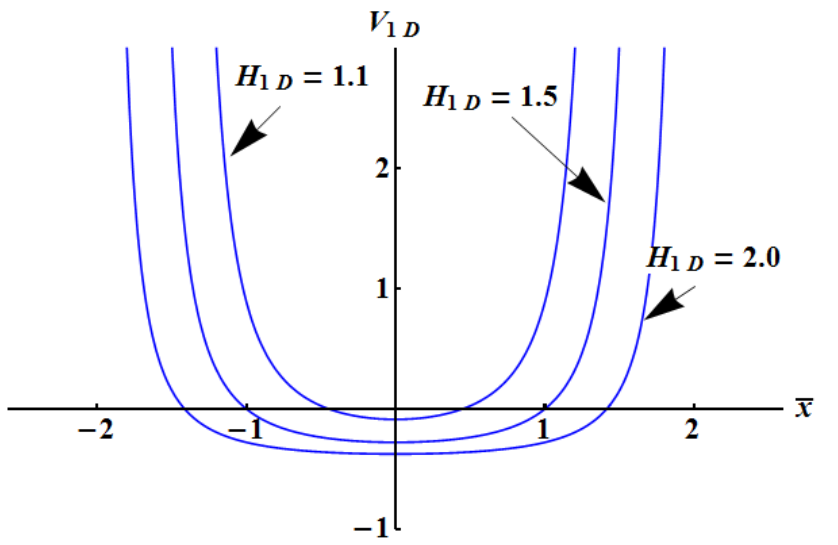
Figure 2. Pseudo-potential V 1 D ( ¯ x ) from Equation (34) and different values of H 1 D , as